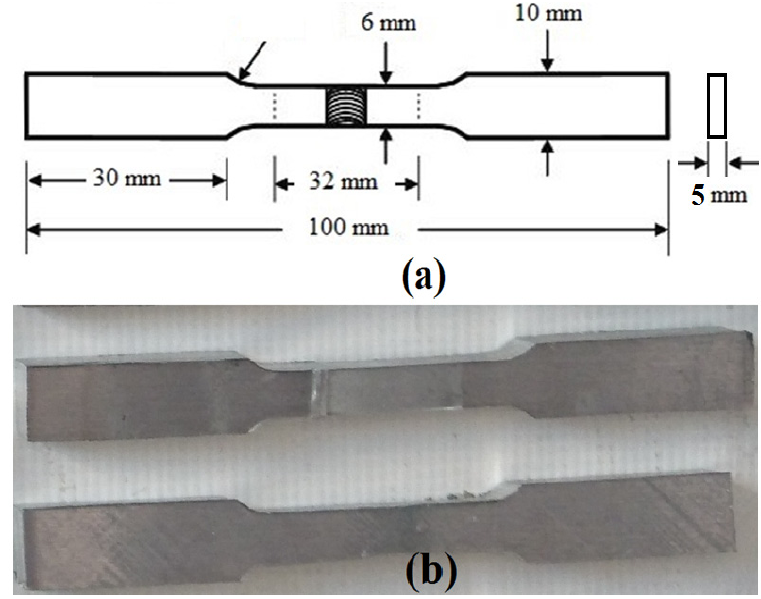
Figure 2. ( a ) The schematic view and ( b ) image of tensile test samples.